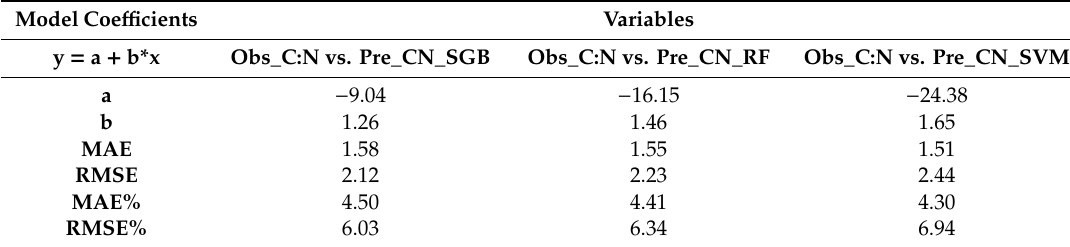
Figure 2. Scatter plot of observed leaf carbon to nitrogen (C:N) ratio versus predicted leaf C:N by of stochastic gradient boosting ( a ) , random forest ( b ) and support vector machine ( c ) methods. The bold point (blue) indicates the value of C:N in each plot. Red and black lines indicate the 1:1 reference line and best fit linear, respectively. Table 4. Internal validation statistics of observed (field) versus predicted C:N ratio of stochastic gradient boosting (SGB), random forest (RF), and support vector machine (SVM). a: intercept and b: